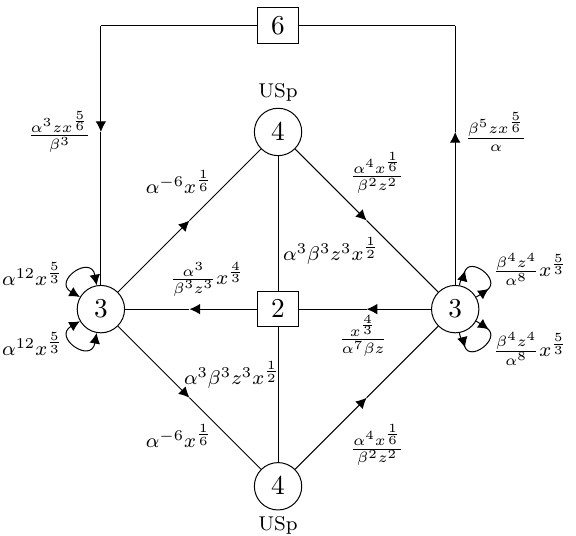
Figure 24 . The theory obtained from the compactification of the SU(2) × SO(16) 5 d SCFT on a torus with flux (0 , 0; 1 , 1 , 0 , 0 , 0 , 0 , 0 , 0) preserving a U(1) × SU(2) 2 × SO(12) symmetry. This theory is obtained by gluing two copies of the tube model in figure 23 and is dual to the (6 , 2) model of subsection